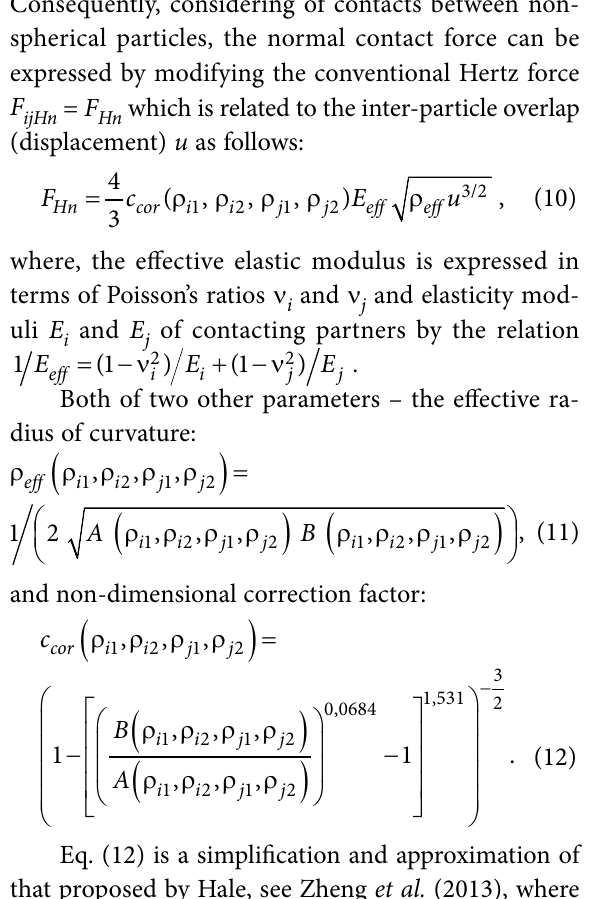
Fig. 6. Three-dimensional views of particles: a) quasi-ellipsoid with sharp edge, b) resultant quasi-quadric composed various